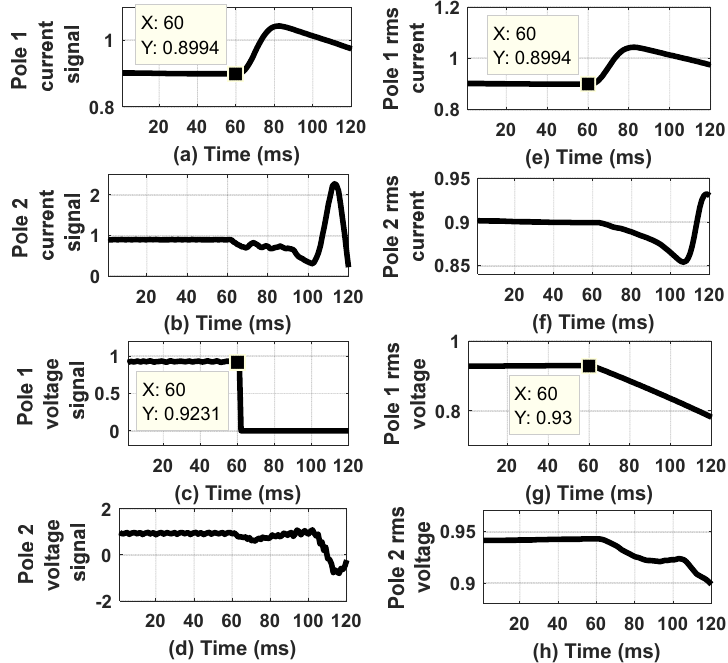
Figure 3. Signals obtained during P1G fault at 150 km in 100 ms time in transmission lines.